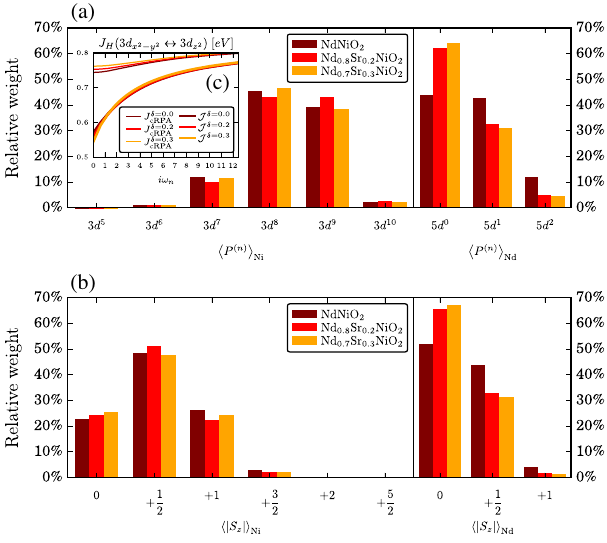
FIG. 2. Occupation and spin statistics for Ni and Nd. (a) Prob- ability distributions for the Ni (left) and Nd (right) atoms to be in the indicated charge states. (b) Probability distributions for the absolute value of the z component of the spin. The different colors correspond to different hole dopings (dark red, undoped; red, close to optimal doping; orange, overdoped). (c) Frequency and doping dependence for the Hund coupling between Ni- 3 d and Ni- 3 d z 2